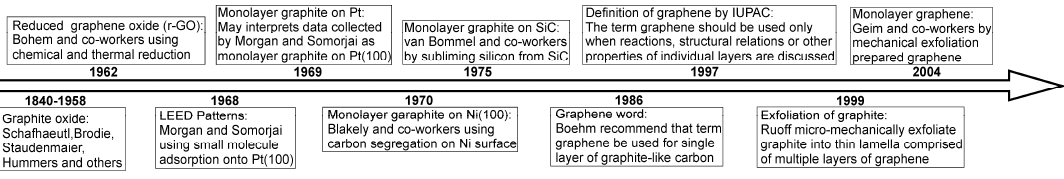
Figure 1. History of graphene.